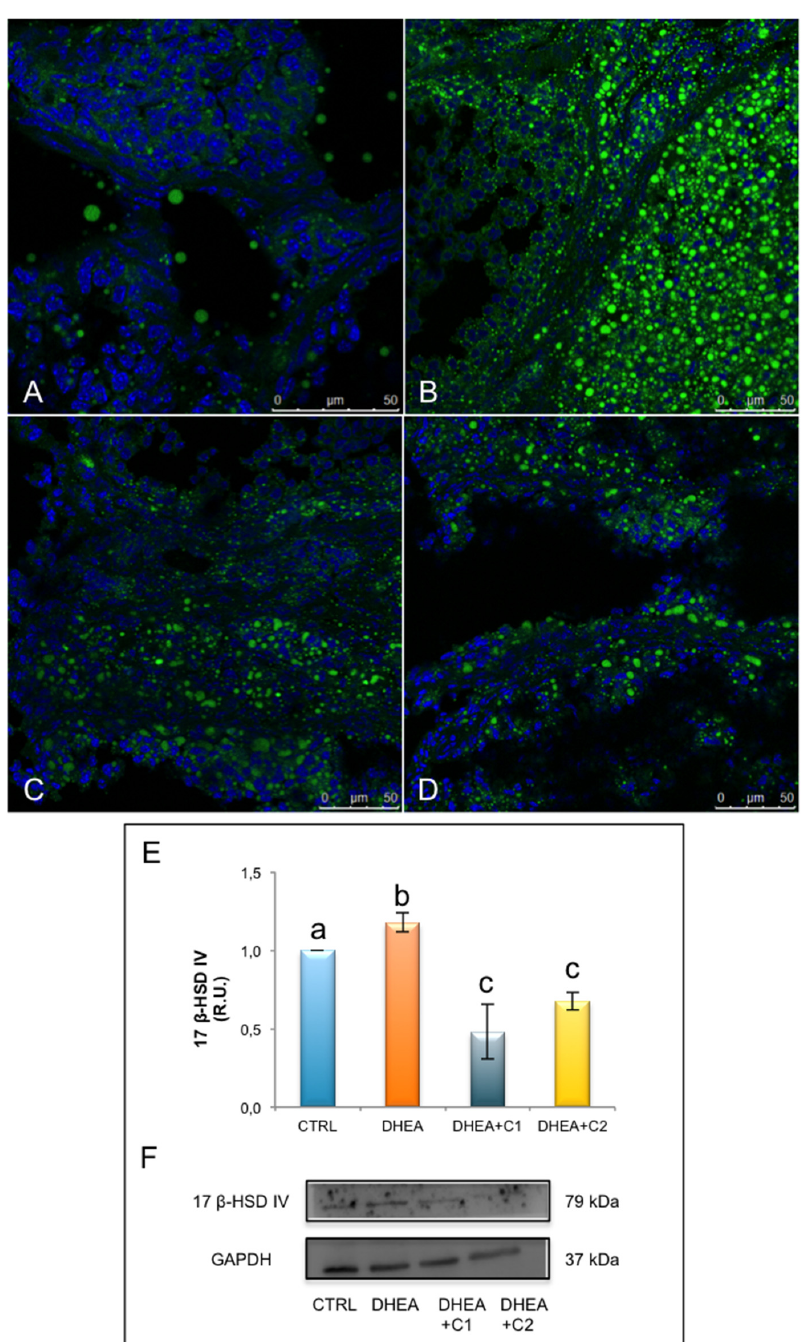
Figure 4. Administration of carnitine formulations reduced lipid content and expression of 17ß-HSD IV, a key enzyme of steroidogenesis. Part of the fixed ovaries were staining by BODIPY 493 / 503 (green). Representative images of CTRL ( A ), DHEA ( B ), DHEA + C1 ( C ), and DHEA + C2 ( D ) ovaries are shown. DNA is stained by Dapi (blue). Part of the ovaries was processed for protein analysis. Western blot analysis of 17ß-HSD IV ( E ) and representative images ( F ) are shown. Data are presented as means ± SEM of densitometric analysis of immunoreactive bands normalized to internal reference protein (GAPDH). a, b, c p < 0.05, t